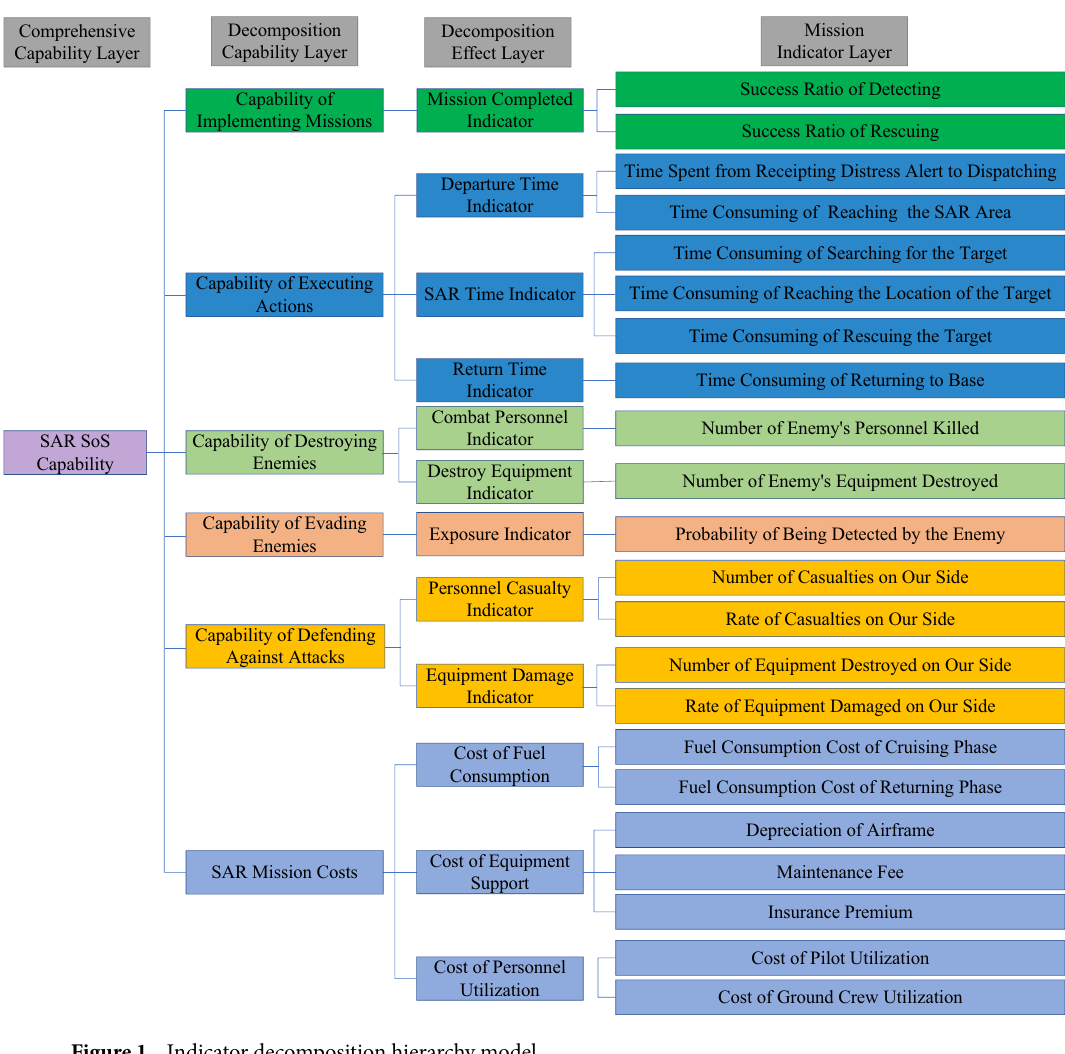
Figure 1. Indicator decomposition hierarchy